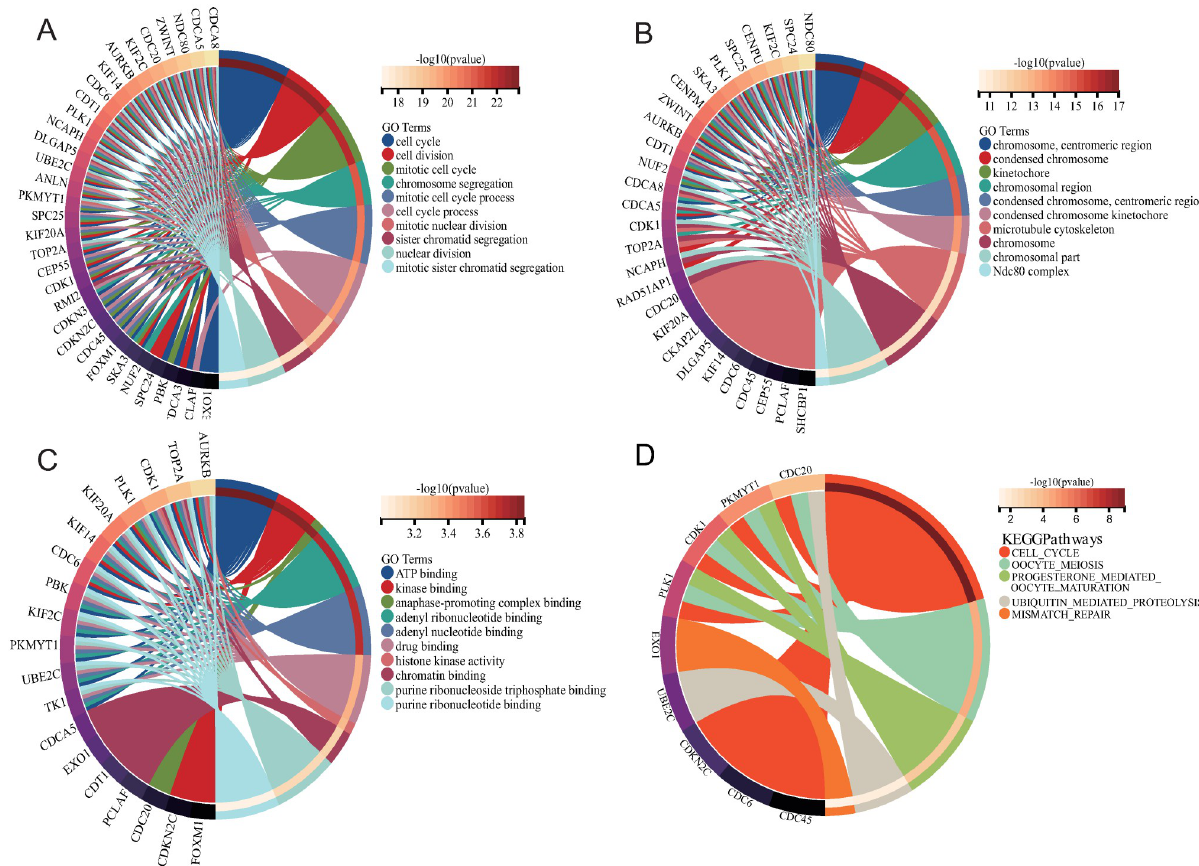
Fig 5. GO and KEGG analysis of COVID-19 myocarditis related to the common genes. (A) Biological Process. (B) Cellular Component. (C) Molecular Function. (D) KEGG pathways analysis.